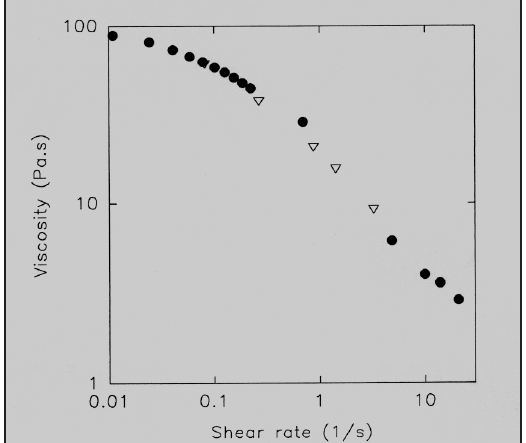
Figure 6 (left): Actual ( ı ) and apparent ( Ê ) steady shear viscosity as a function of imposed shear stress for a 1% w/w hydrophobically modified (hydroxypropyl) guar aqueous solution. The apparent values are determined at a rheometer gap of 500 µm. Figure 7 (right): Steady shear viscosity as a function of actual ( ı ) and apparent ( Ê ) shear rate for a 1% w/w hydrophobically modified (hydroxypropyl) guar aqueous solution. The apparent values are determined at a rheometer gap of 500